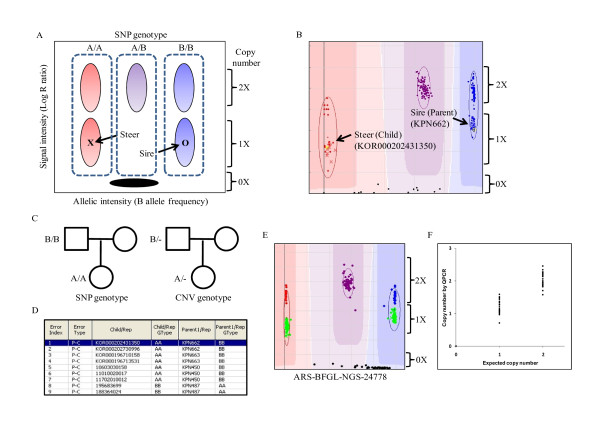
Scheme of identification of common deletion polymorphisms by parent (sire)--child (steer) heritability (P-C) error and validation by quantitative PCR. (A) Scheme of genoplot image in Illumina BeadStudio 3.2 software where SNP marker was located within copy number variation region. Steer and sire were marked as "X" and "O", respectively. The three dotted lines represent three SNP genotypes (A/A, A/B, and B/B). (B) Genoplot image showing P-C heritability error. The steer (child) is shown on the left side (copy number: 1×; CNV genotype: A/-; marked at "X") and its sire (parent) on the right (copy number: 1×; CNV genotype: B/-; marked at "O"). (C) Difference of SNP and CNV genotype in one pedigree. (D) Heritability error table. Nine P-C errors in one marker are displayed. The table shows the sample ID of steer (child) and sire (parent) and their SNP genotypes having heritability error. (E) Genoplot image of identified common deletion polymorphisms (marker name: ARS-BFGL-NGS-24778). Three types of copy number (2×, 1×, and 0×) are depicted. Individuals having hemizygous deletions (copy number: 1×) clustered into two distinct groups (color: cyan). Samples having null copy number are displayed with a black dot at the bottom. (F) Validation by qPCR around the ARS-BFGL-NGS-24778 marker. The individuals having homozygous (null) and hemizygous deletions in the genoplot image were spotted approximately in the same copy number position by qPCR.